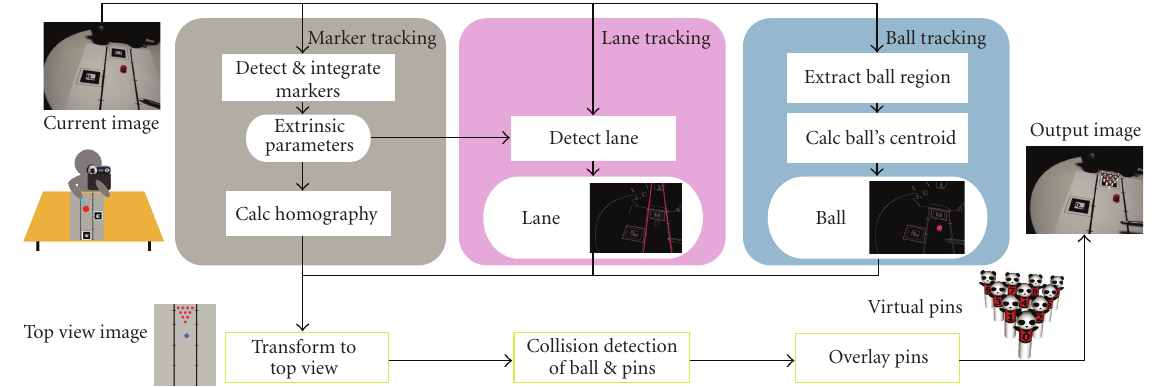
Figure 13: Overview of Interactive AR Bowling System.